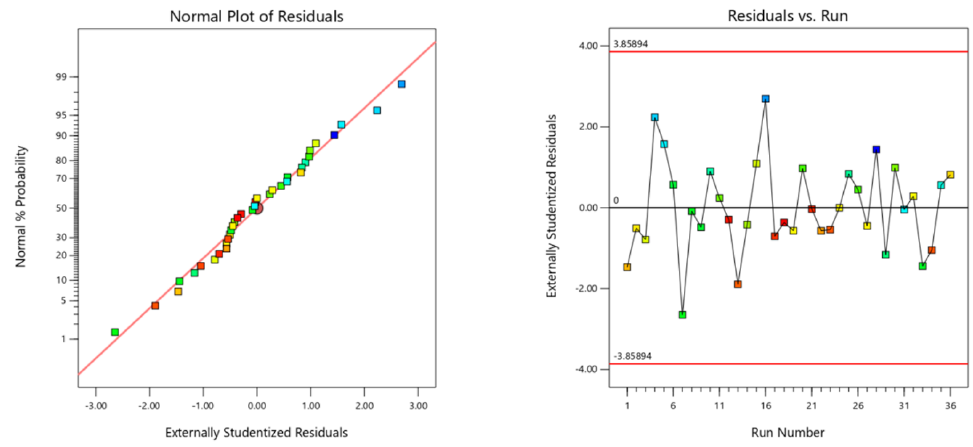
Figure 6. Normal probability and residual vs. run